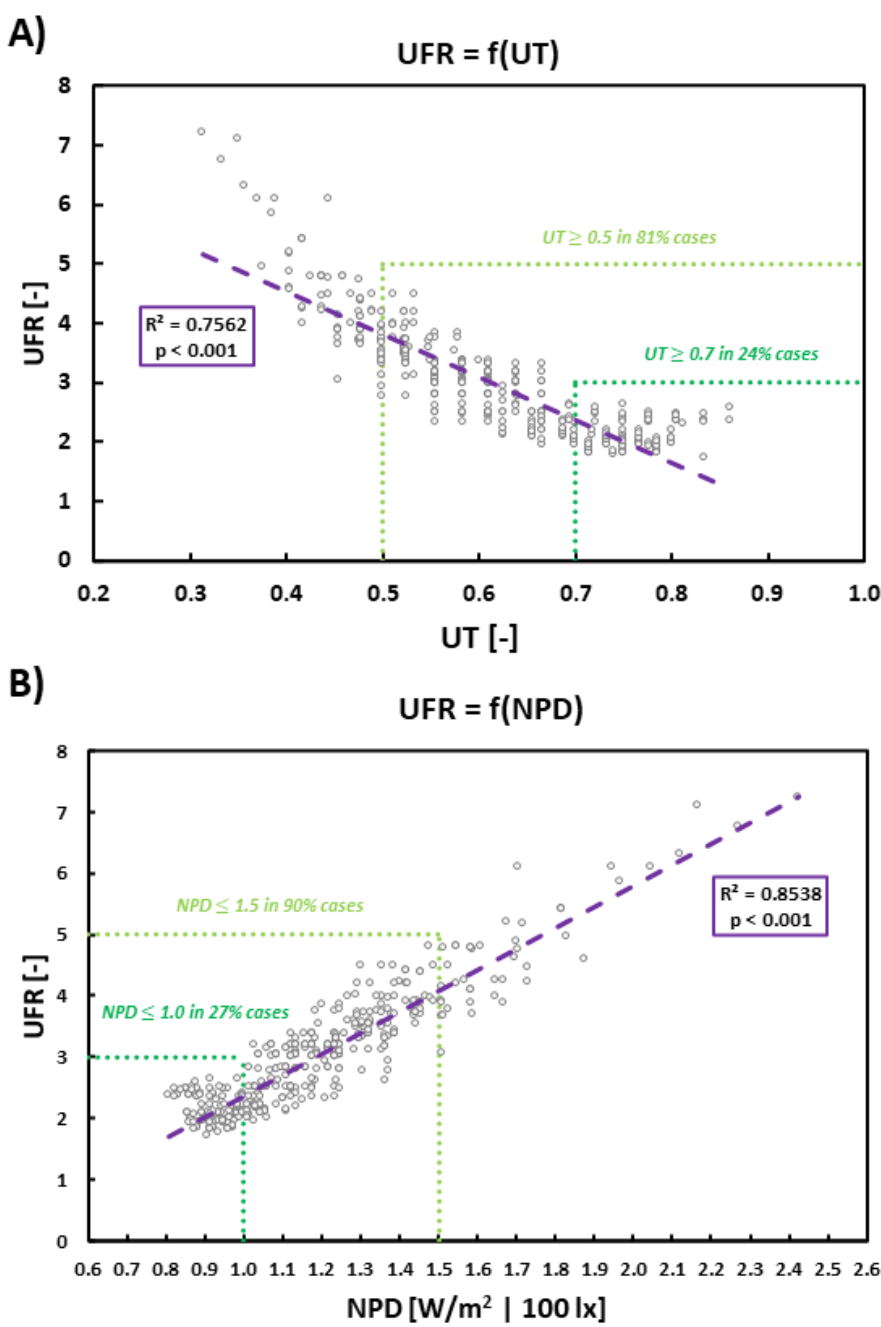
Figure 8. The linear correlation between particular parameters: ( A )—Upward Flux Ratio and Normalized Power Density, ( B )—Upward Flux Ratio and Utilance.